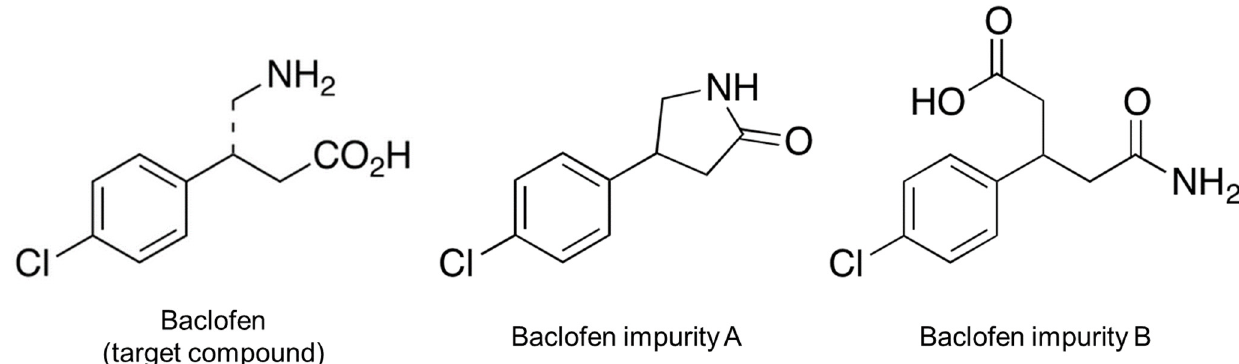
Figure 1. Structure of baclofen and its impurities.